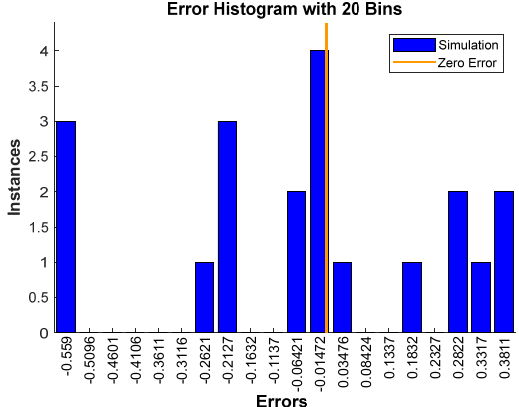
Figure 6. Regression of simulated data for ANN model .